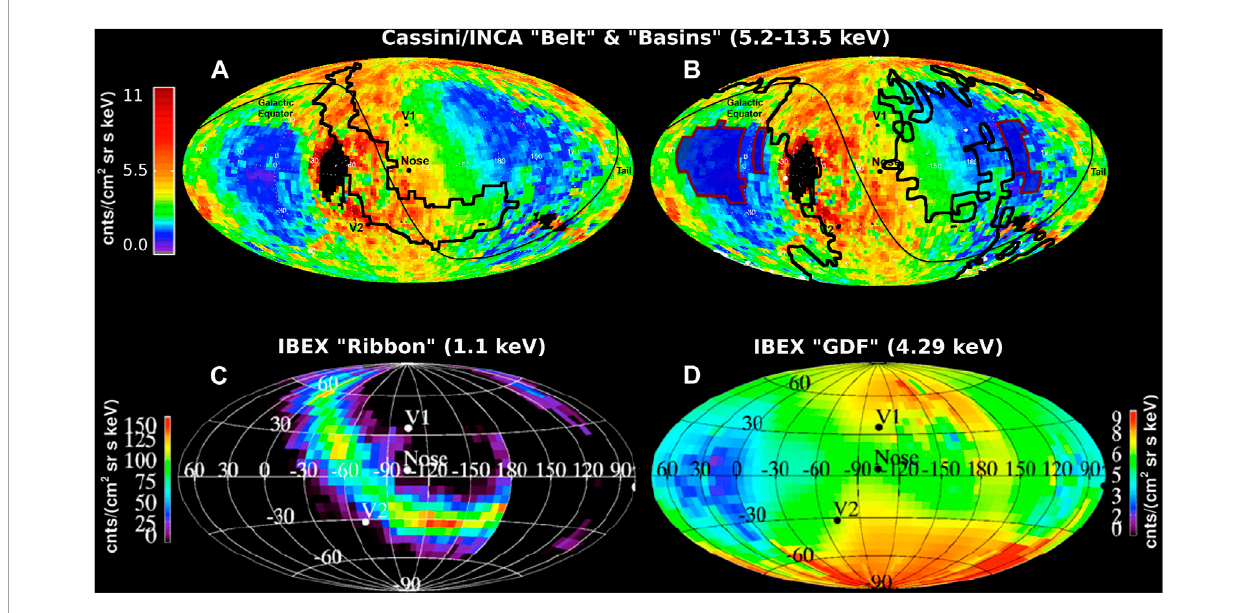
FIGURE 4 (Top) Image of heliospheric ENAs in the range of ∼ 5.2 to 13.5 keV, in ecliptic coordinates showing the “Belt” and the “Basins”, as detailed in the text. The black outlines at each image enclose the regions of maximum ENA intensities of (A) IBEX-Hi at ∼ 1.1 keV and (B) IBEX-Hi at ∼ 4.29 keV (Dialynas et al., 2013) (Bottom) Image of heliospheric ENAs from IBEX at (C) ∼ 1.1 keV showing the “Ribbon” and (D) ∼ 4.29 keV showing the ENA fluxes from the GDF (Schwadron et al.,